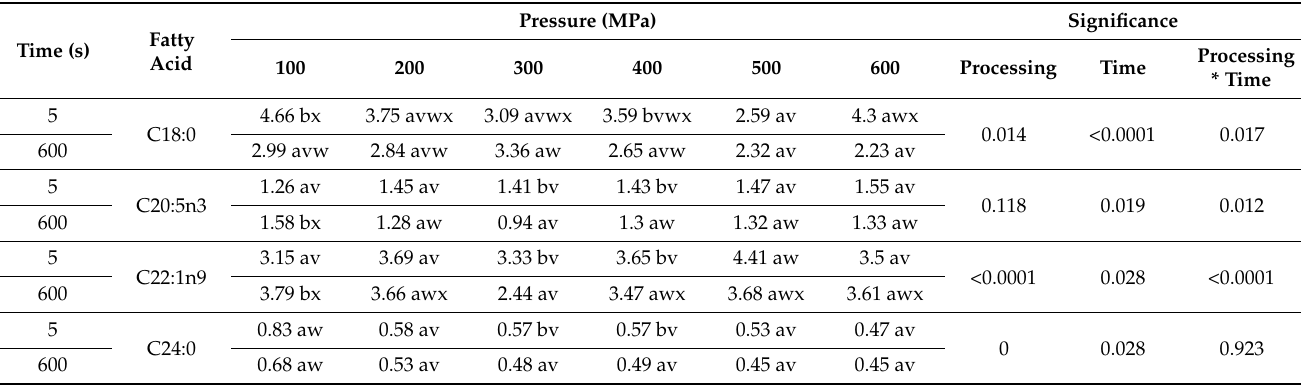
Table 4. Fatty acid composition of Storm Shell ( Mactra murchisoni ) clam. a,b means with different letters within a row show the significant effect of time for each processing pressure; v,w,x,y,z means with different letters within a column shows the significant effect of time under the same processing pressure. * Compounds identified with VID coefficients higher than